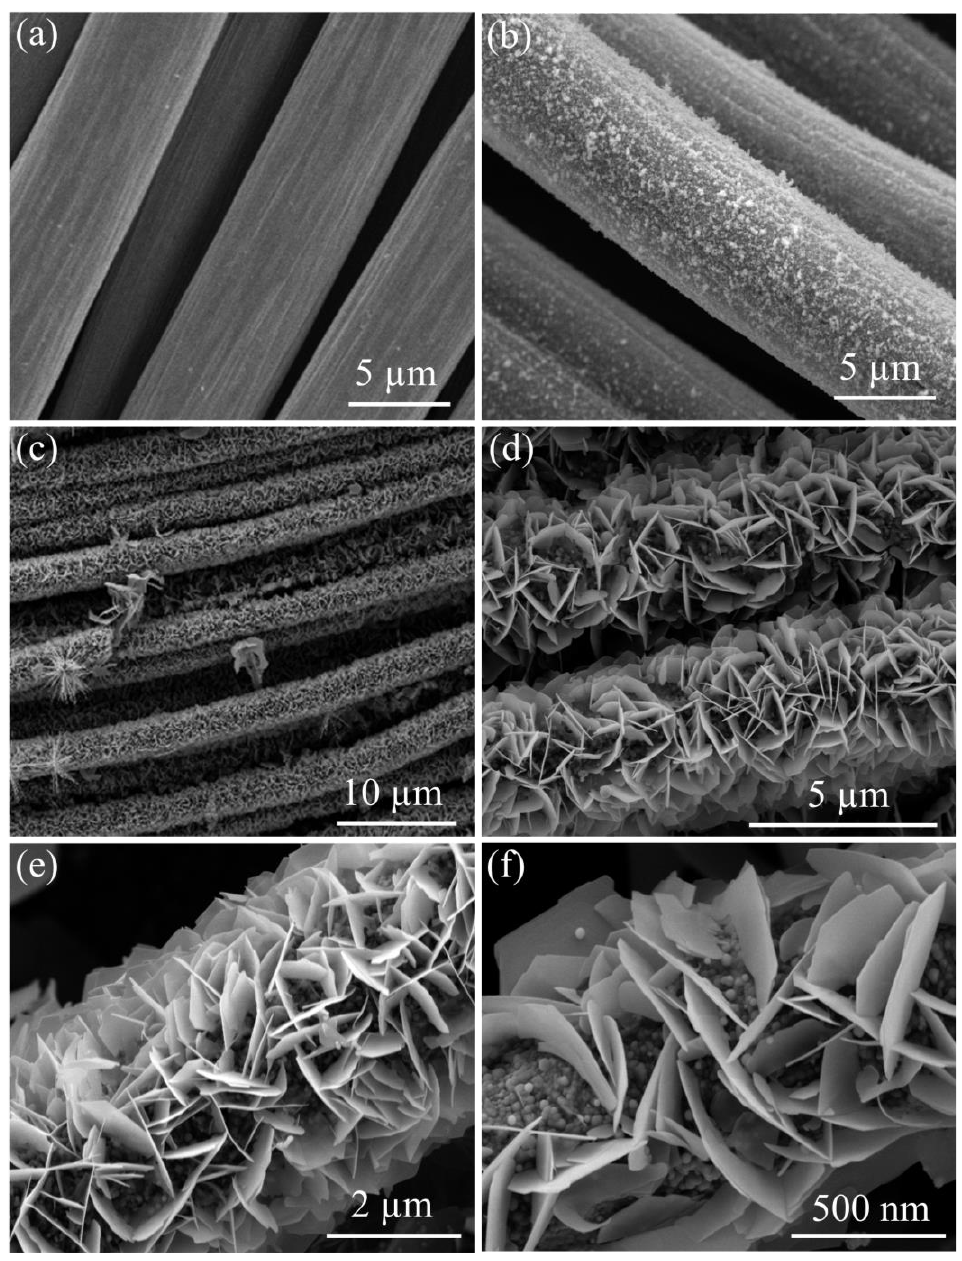
Figure 2. FESEM images of ( a ) CC; ( b ) ZnO@CC; ( c , d ) Low-magnification FESEM images of CoFe-LDH@ZnO@CC; ( e ) High-magnification FESEM images of CoFe-LDH@ZnO@CC; ( f ) an enlarged view.